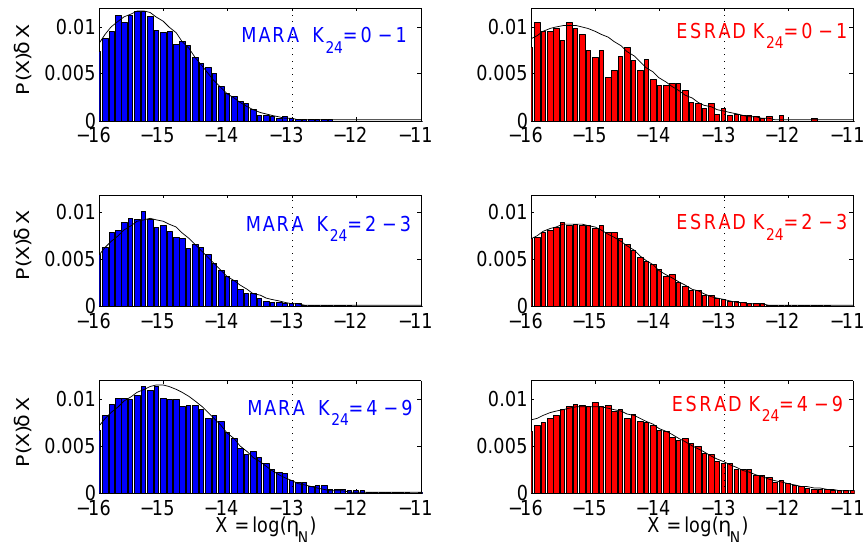
Fig. 5. Histograms showing the occurrence rate of PMSE as a function of volume reflectivity ( η N ) for different levels of magnetic dis- turbance. Occurrence rates are based on 1-h averages – the months of June and July at ESRAD, December and January at MARA – and include observations for all heights (600-m resolution) between 78 and 100km a.s.l. Black curves are fitted lognormal distributions with characteristics given in Table 2.